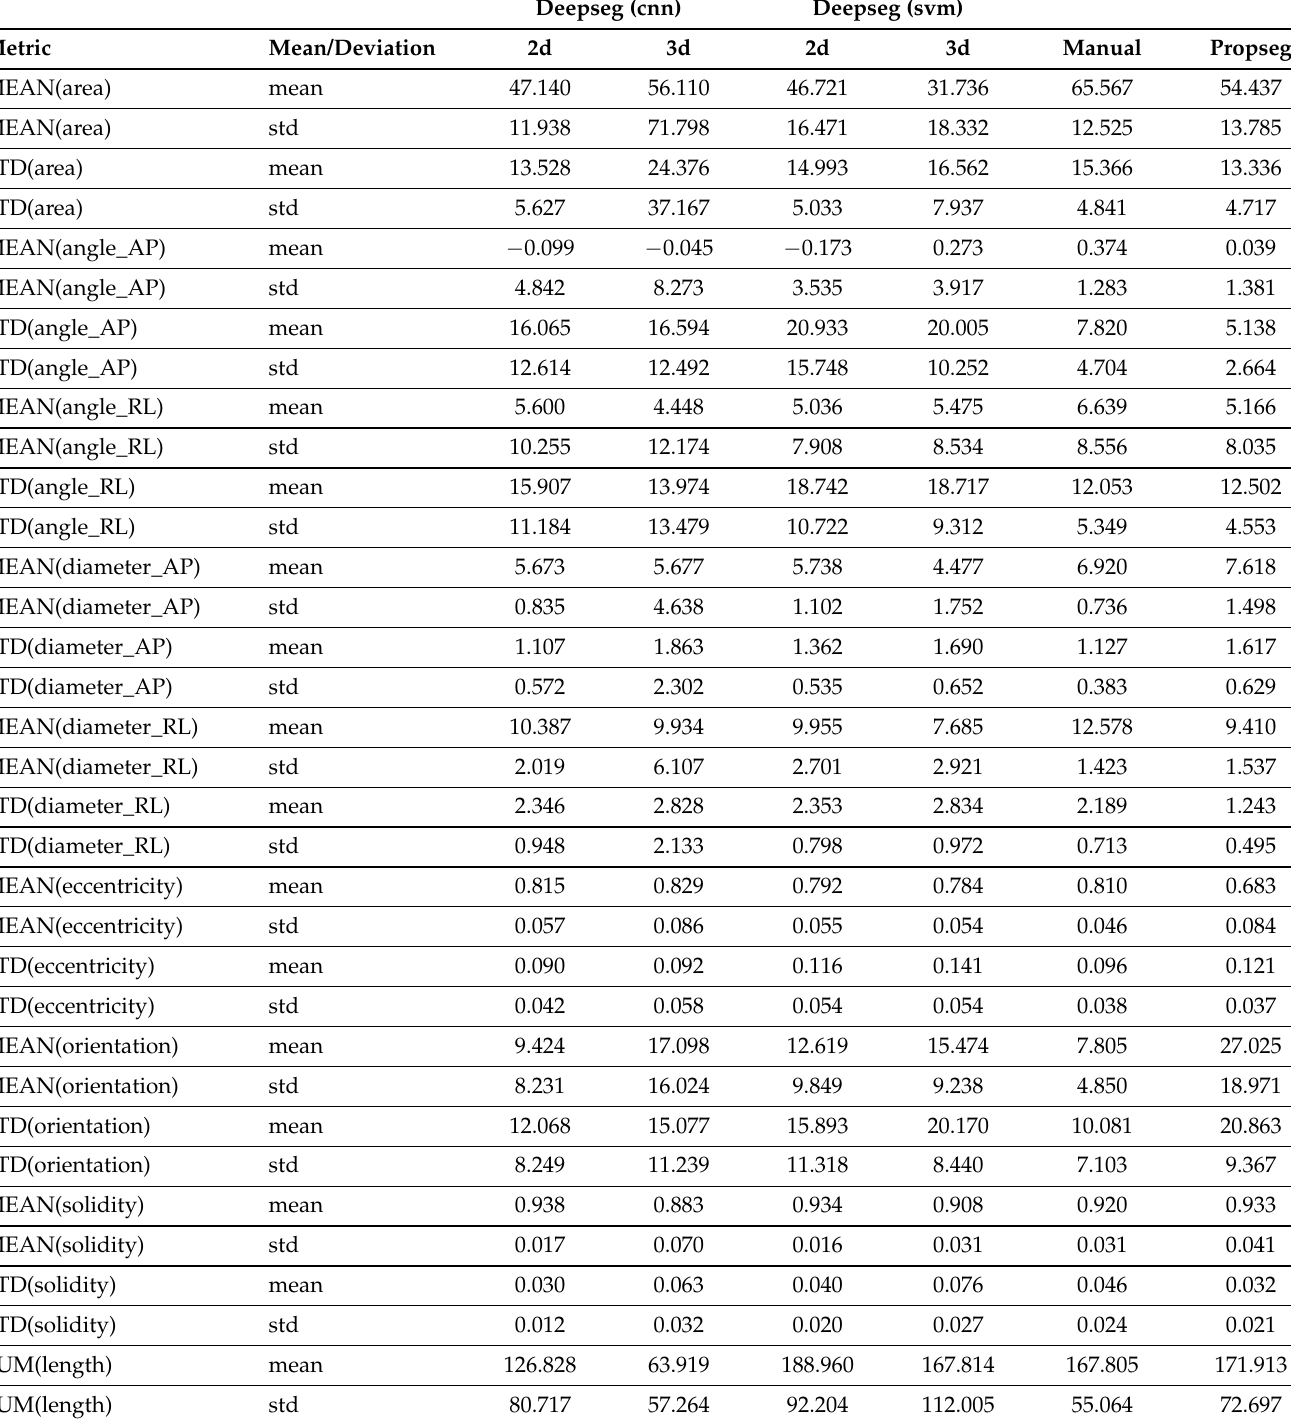
Table 3. Variation of metric measures across automated segmentation methods. A visualized version of this data, alongside statistical assessments, can be found in Figure